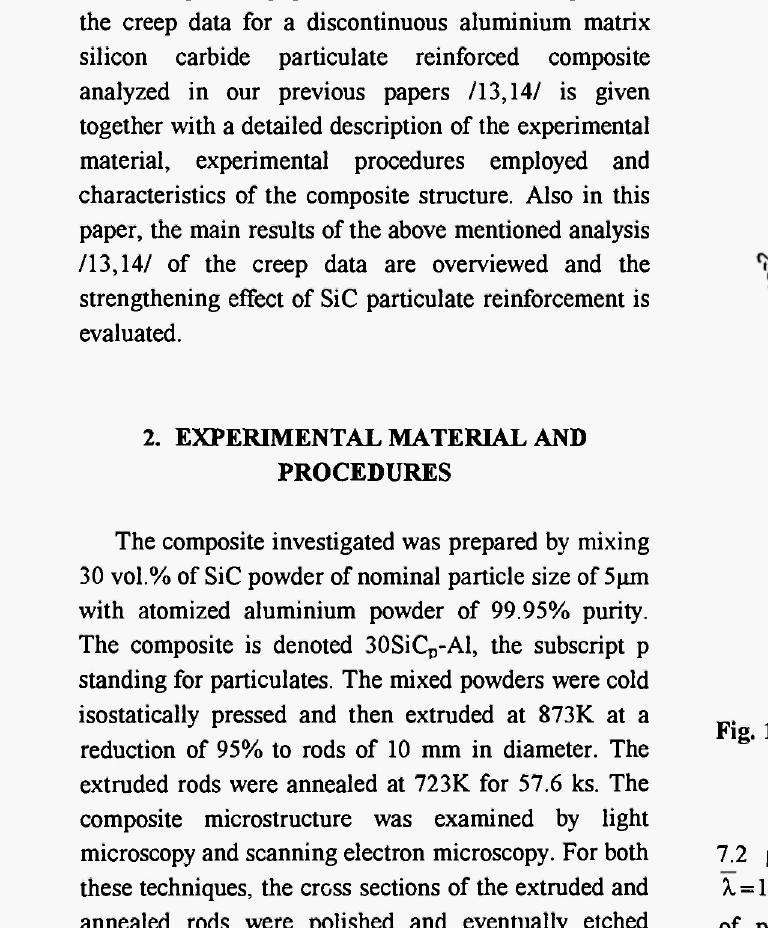
7.2 μπι following from the formula (c.f. ref. 15) λ = 1.2/Vn, where Ν = 2.77 χ 10 10 nr 2 is the